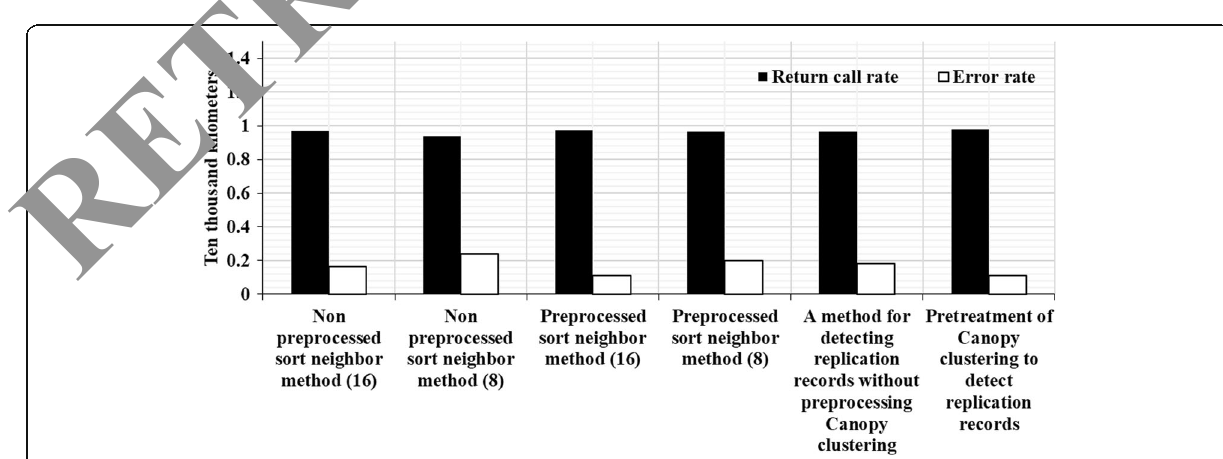
Fig. 4 The results of comparing pretreatment and non-preprocessed